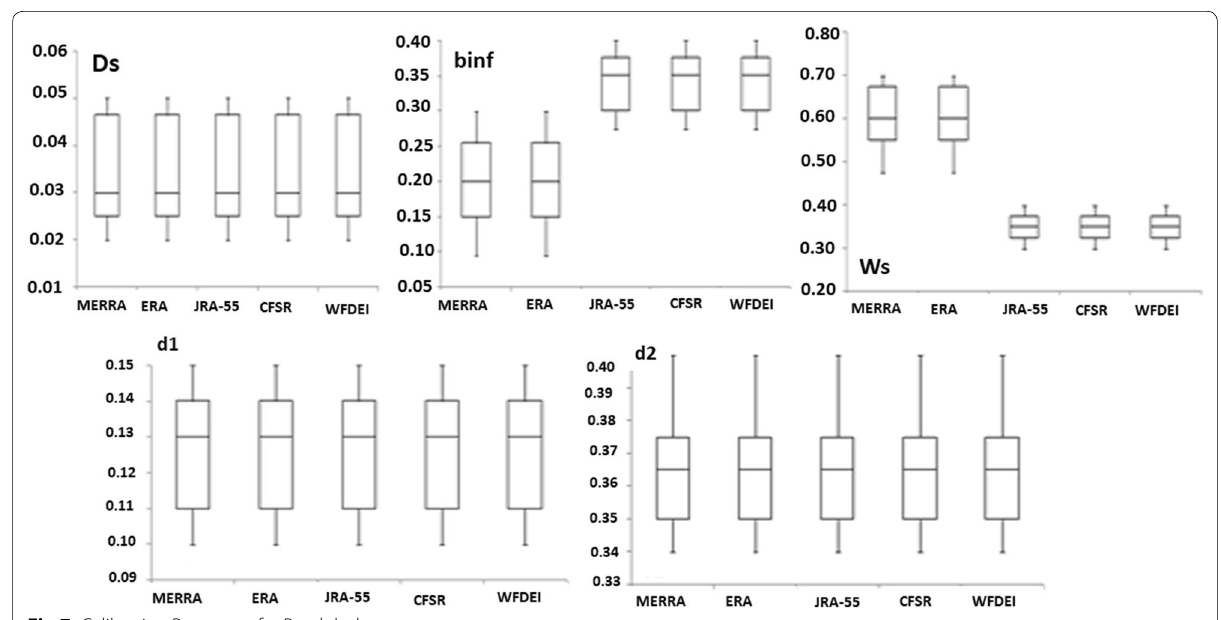
Fig.7 Calibration Parameter for Pandoh